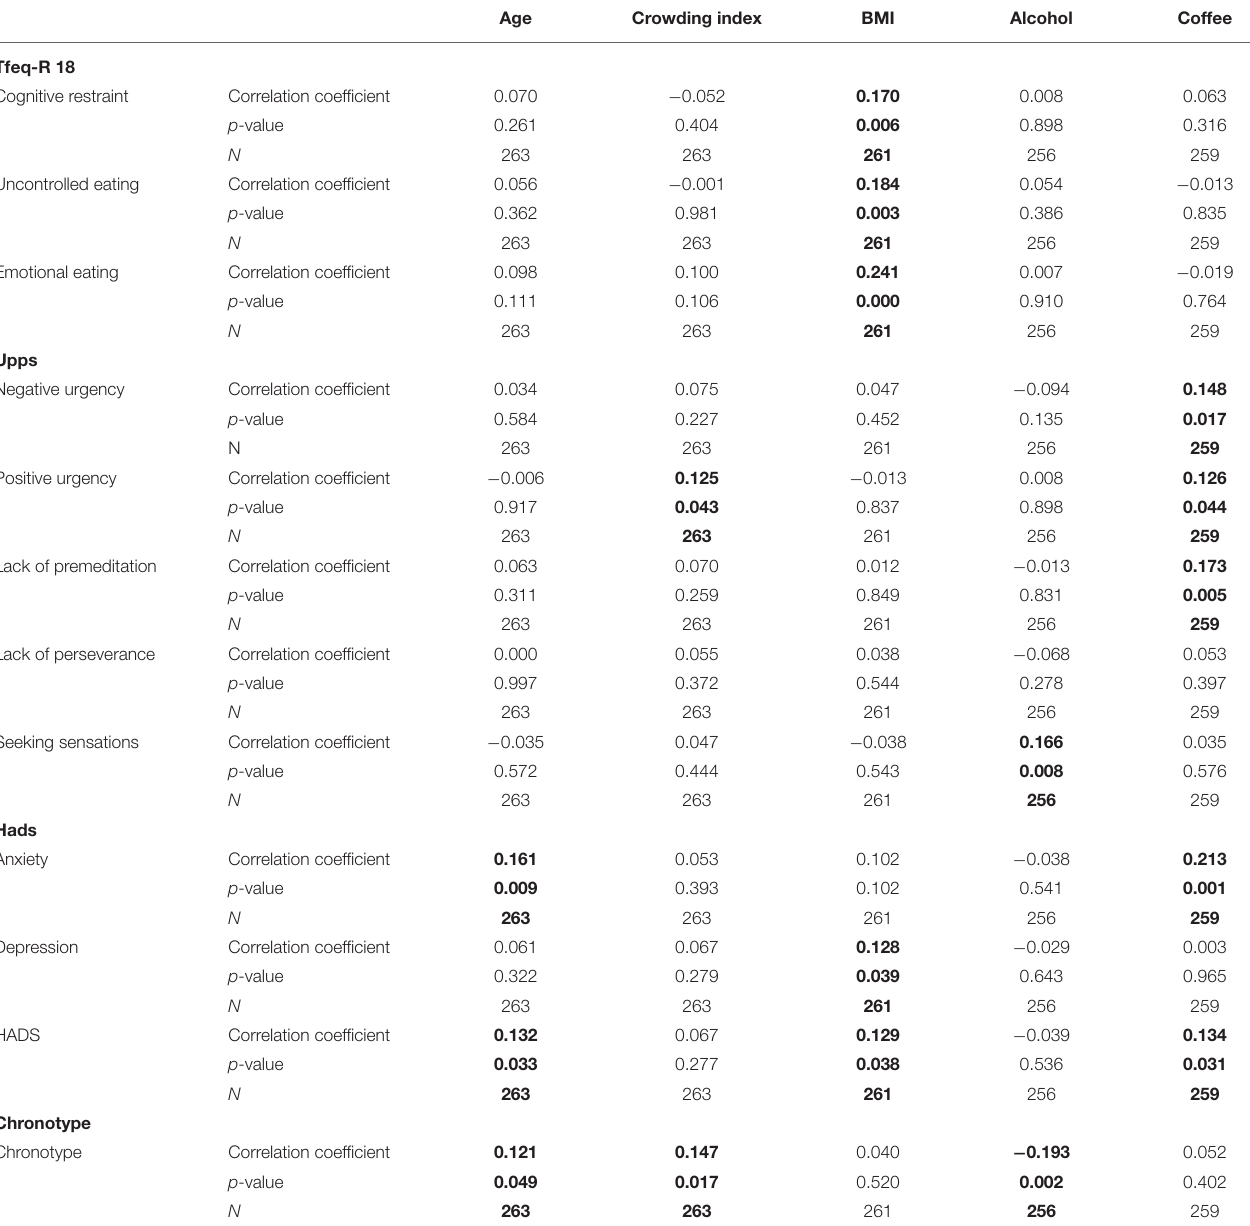
TABLE 4 | Associations between the different components of the questionnaires and the continuous socio-demographic characteristics of female participants ( N =